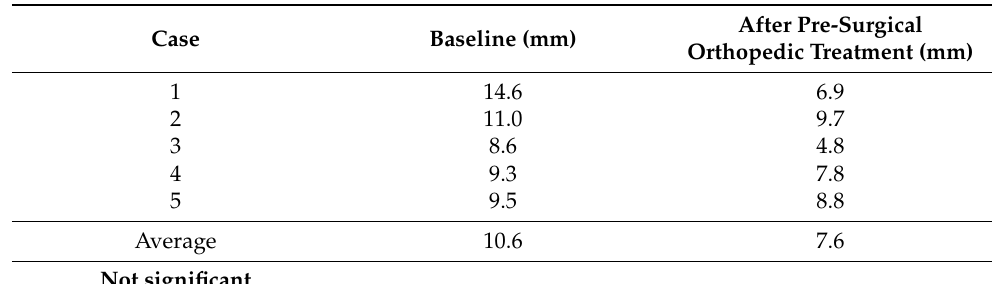
Table 3. Comparison of cleft lip width measured at baseline and after pre-surgical orthopedic treatment (lower point).